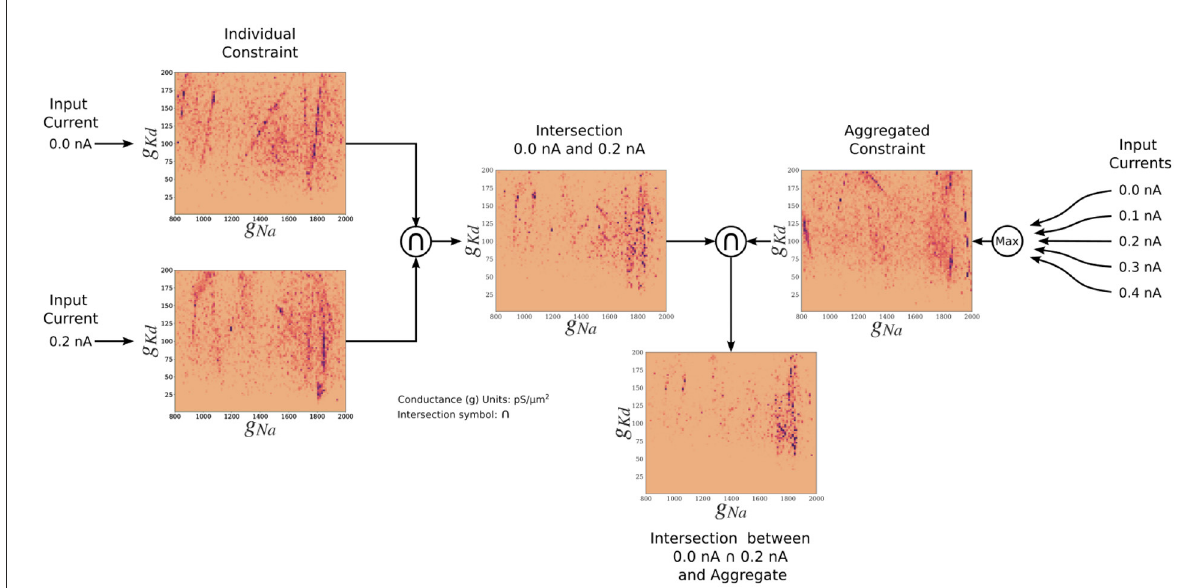
FIGURE5 Two-dimensional ( g Na and g Kd ) kernel density estimates (KDEs) of the solution maps of different cases, for visualization of the relationship between the aggregate constraint and the individual constraints. The arrows indicate the flow of the operation. The KDEs of the 0.0 and 0.2 nA individual constraints are on the left. The KDE of the aggregate constraint is shown on the right. The intersection is the elementwise multiplication of two or more KDEs. The final intersection between 0.0, 0.2 nA, and aggregate constraint shows the contribution of the 0.0 and 0.2 nA individual constraints to the aggregate constraint. The colormap scales have been adjusted so that values are